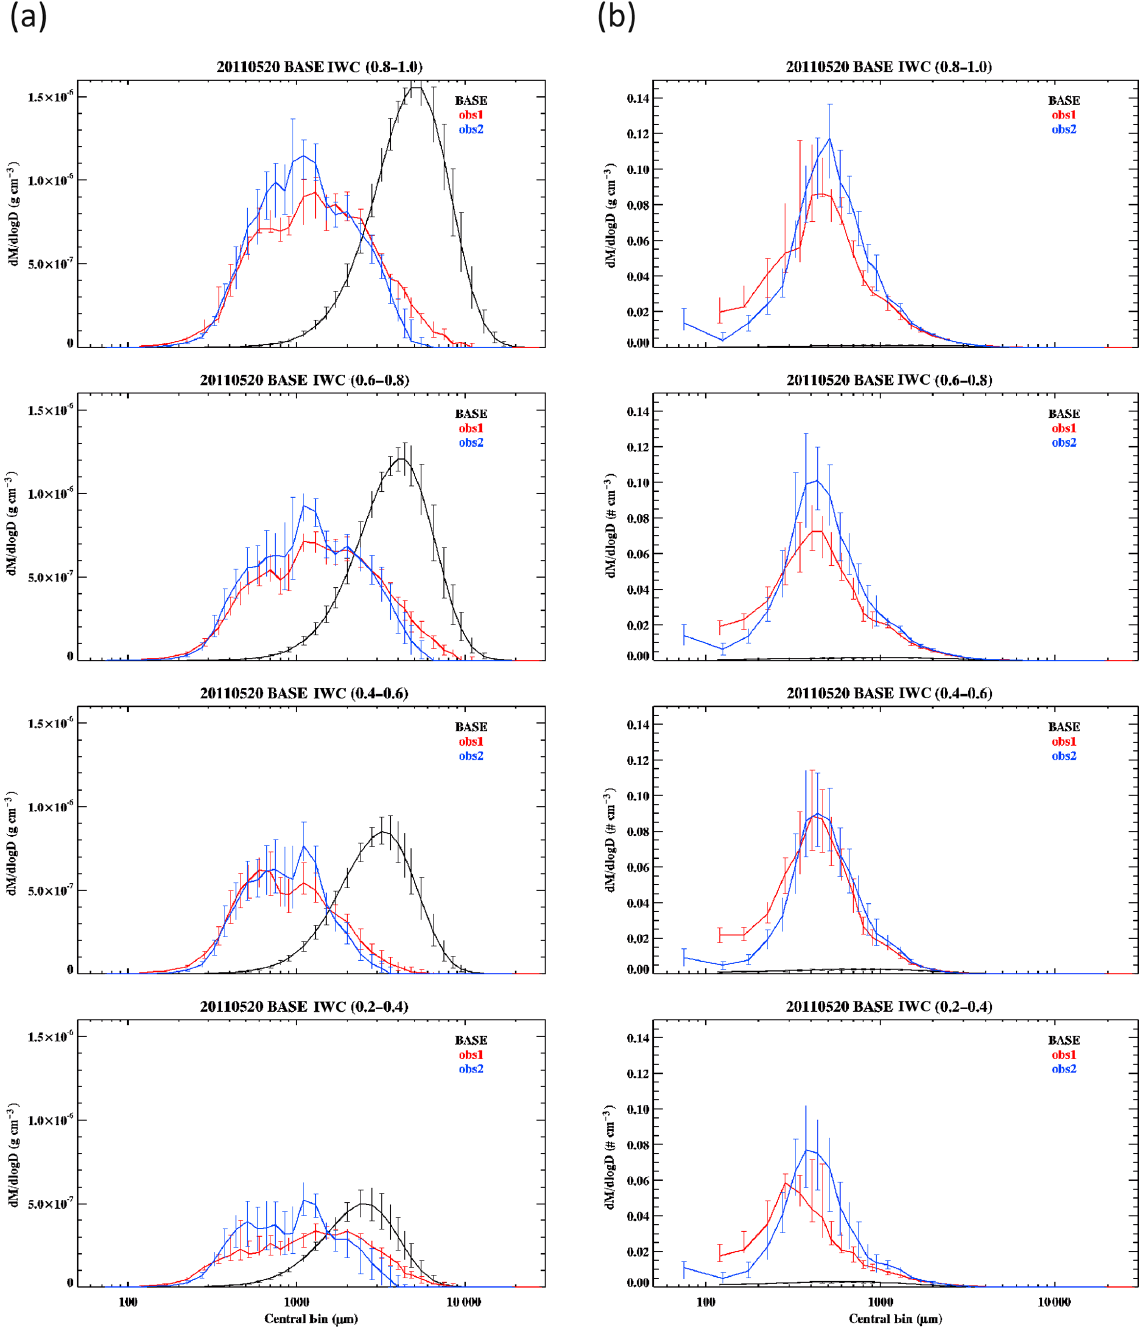
Figure 11. Size distributions of ice mass (a) and number (b) in four ranges of ice water content (IWC; ranges in parentheses in gm − 3 ) derived from the merger of two-dimensional cloud (2DC) and high-volume precipitation spectrometer (HVPS) raw data independently by Wang et al. (2015a, “obs1” in red) and Wu and McFarquhar (2016, “obs2” in blue). Both are shown as an estimate of poorly established uncertainty. Also shown are size distributions from the BASE simulation (black) at 5.8km ( − 11 ◦ C) within the respective red-bounded geographic regions shown in Fig. 9. Simulated ice is the sum of all ice classes at each size. The simulated ice bin size is the sphere diameter calculated from the bulk density of each ice class. The measured ice size is the randomly oriented maximum dimension. Error bars indicate 1 standard deviation of values simulated or observed at each